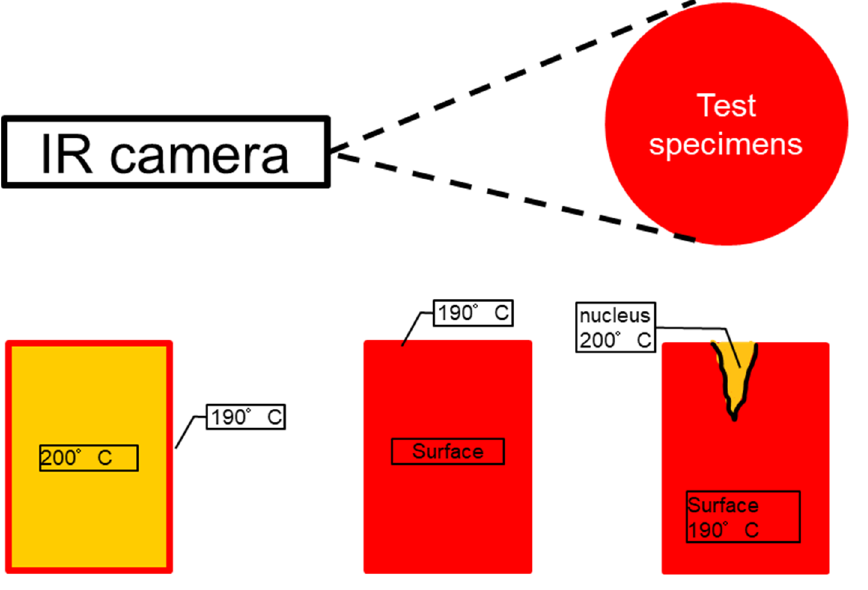
Figure 2. Schematic representation of the crack detection. The challenge that arises here follows from the rapid cooling of the surfaces created by the crack. As a result, the video recording must be faster (FPS) than the cooling of the crack site. Furthermore, only the cracks that are in the recording range of the IR camera can be detected. The IR camera VarioCAM (see Table 2) from the company InfraTec GmbH was used for the tests. With the help of the IRBIS 3 Plus evaluation software, temperatures were recorded and saved during the upsetting process. Minimum, maximum, and average values could be output. It is important to note that the correction factor or emissivity must be adjusted for each material. The emissivity is 0.4–0.5 for ZEP1510, 0.25–0.35 for AlSi1MgMn, and 0.5–0.6 for CuZn39Pb2. This test was also carried out with the materials ZEP1510, CuZn39Pb2, and AlSi1MgMn. The samples have a diameter of 34 mm and a height of 55 mm. The approximate forging temperature was set as the initial temperature for all three materials. This is approx. 250 ◦ C for ZEP1510, approx. 750 ◦ C for CuZn39Pb2, and approx. 500 ◦ C for AlSi1MgMn. In all tests, a dispersion of graphite and water was used as the lubricant. The initial temperature was lowered in 50 ◦ C steps until cracks appeared at the existing degree of deformation. All laboratory-level investigations carried out were proven at least five-fold.